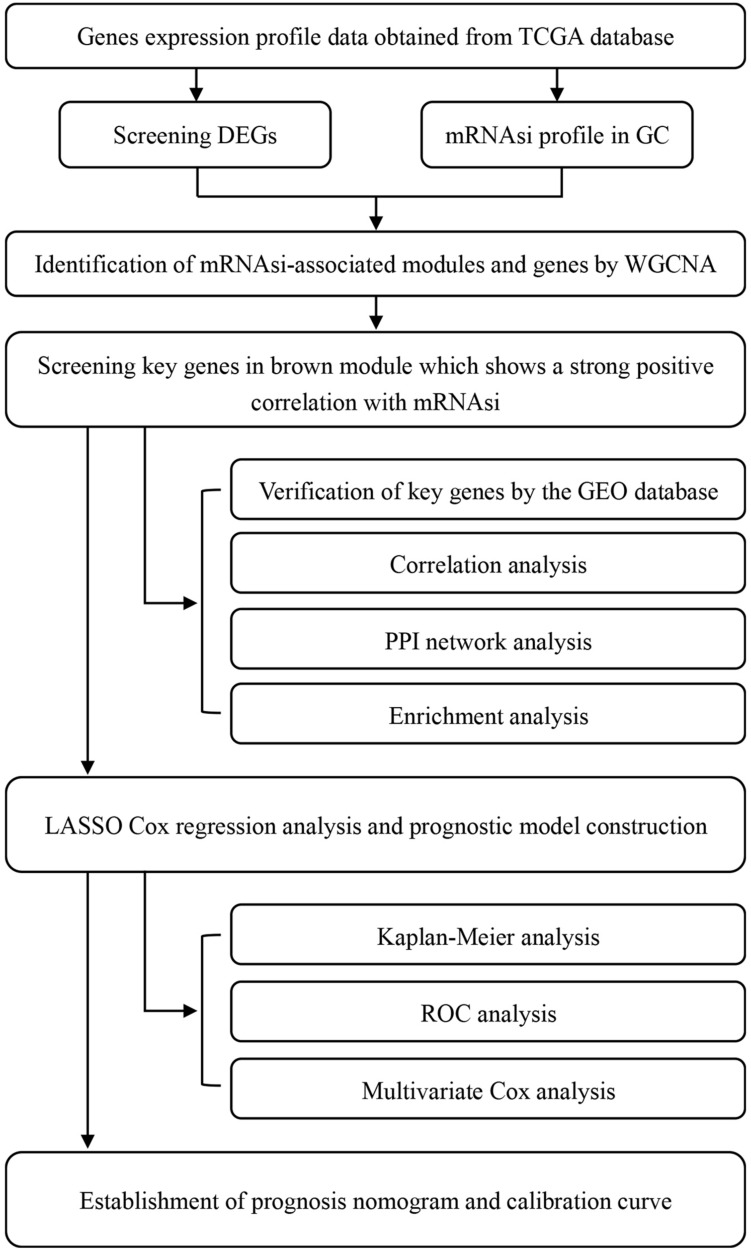
Flow chart of the study design. TCGA, The Cancer Genome Atlas; mRNAsi, mRNA expression-based stemness index; DEGs, differentially expressed genes; GC, gastric cancer; WGCNA, Weighted gene co-expression network analysis; GEO, Gene Expression Omnibus; PPI, protein-protein interaction; LASSO, least absolute shrinkage and selection operator; ROC, receiver operating characteristic.